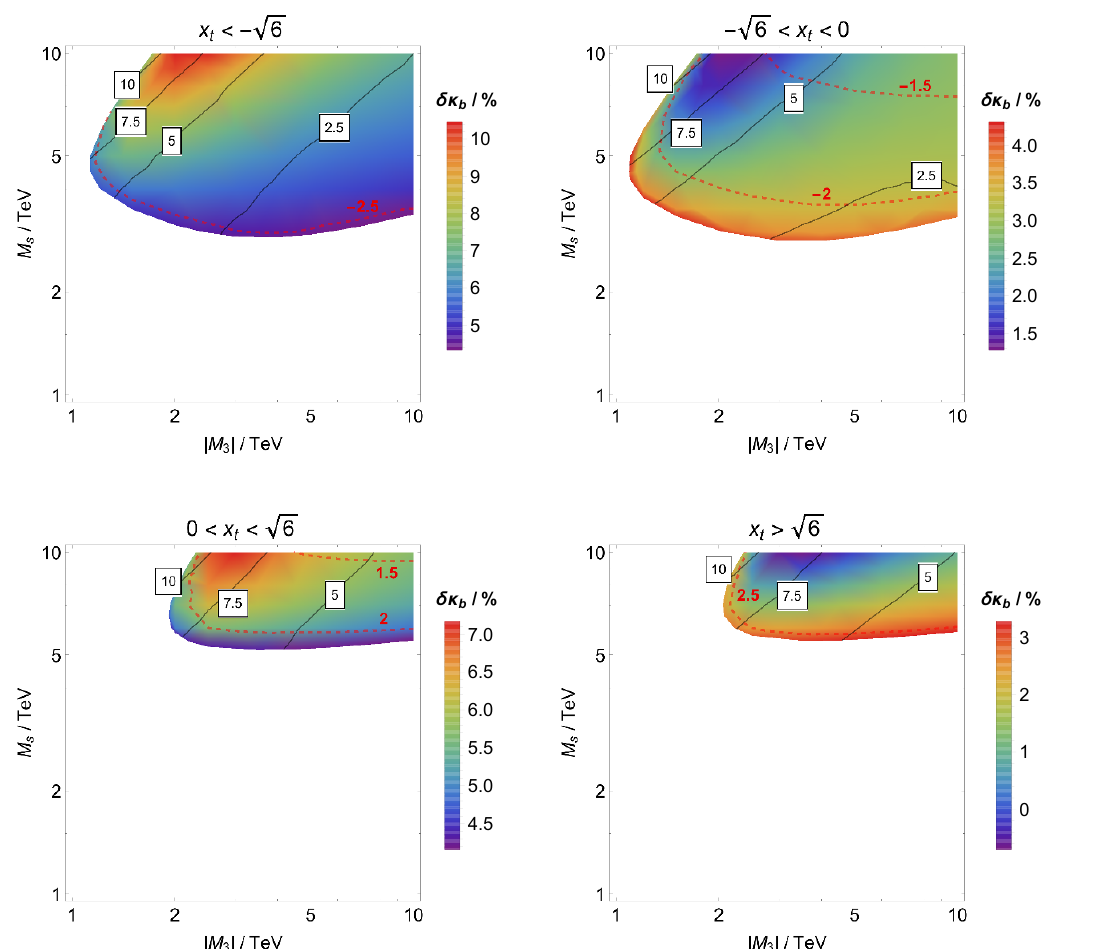
Figure 7 . Same as (cid:12)gure 5, now with tan (cid:12) =